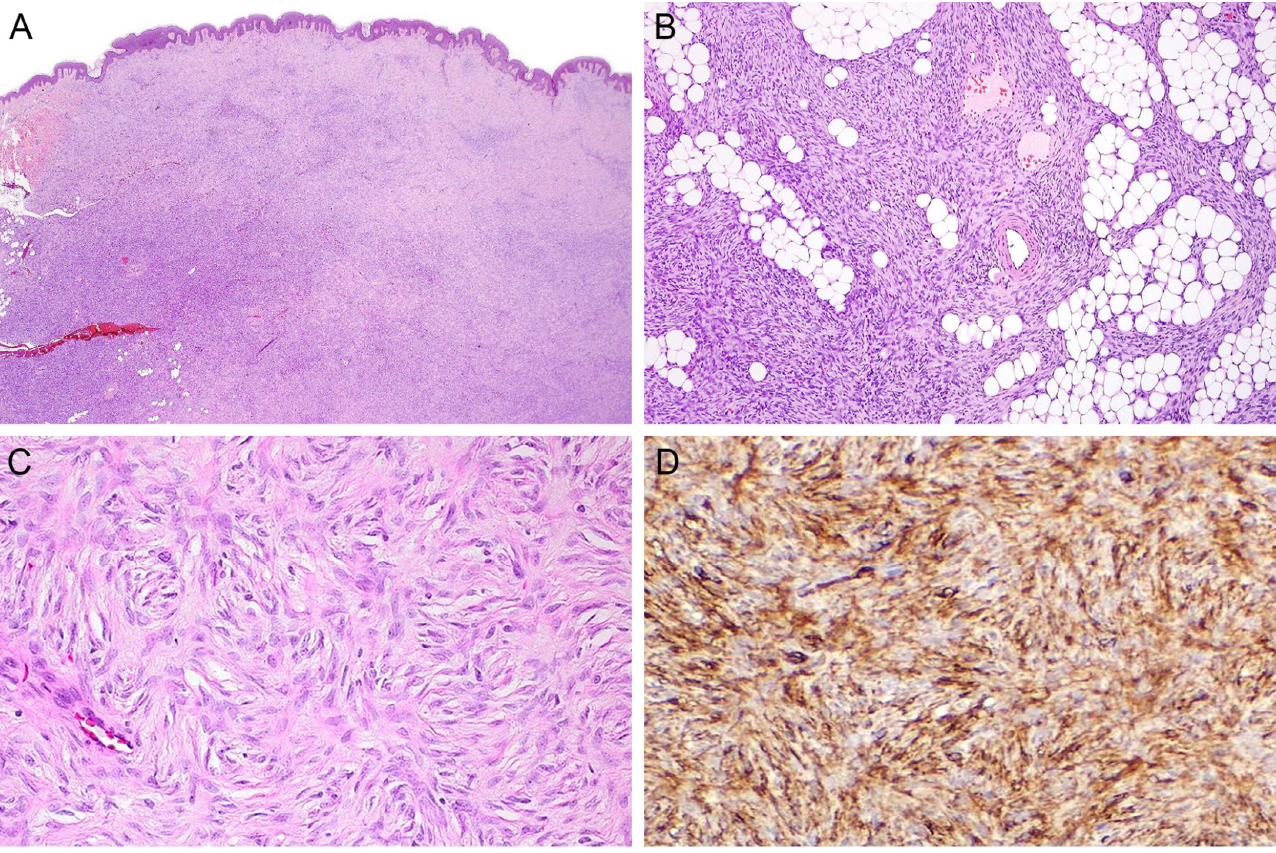
Figure 1. DFSP with classic histomorphology: dermal-based tumor with uniform, spindle-shaped cells (( A ); magnification ×40) arranged in a predominantly storiform pattern (( B ); magnification ×100 and ( C ); magnification ×200). These cells are primarily based in the dermis, with infiltration of the subcutis in a characteristic diffuse honeycomb fashion ( B ). In immunohistochemistry, DFSP shows strong and diffuse positive staining for CD34 (( D ); magnification ×200).